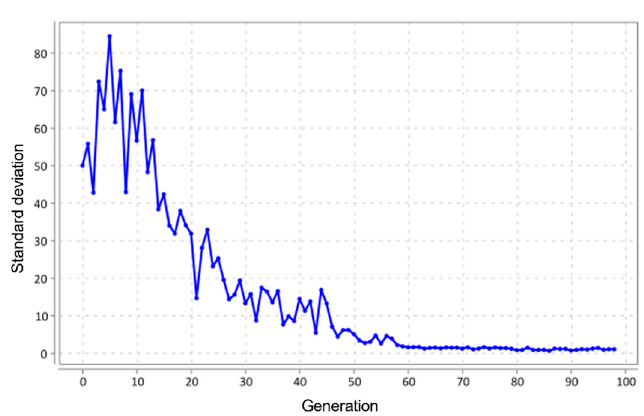
Figure 8 . Example 1: Standard deviation of the objective values of all the individuals at every generation.